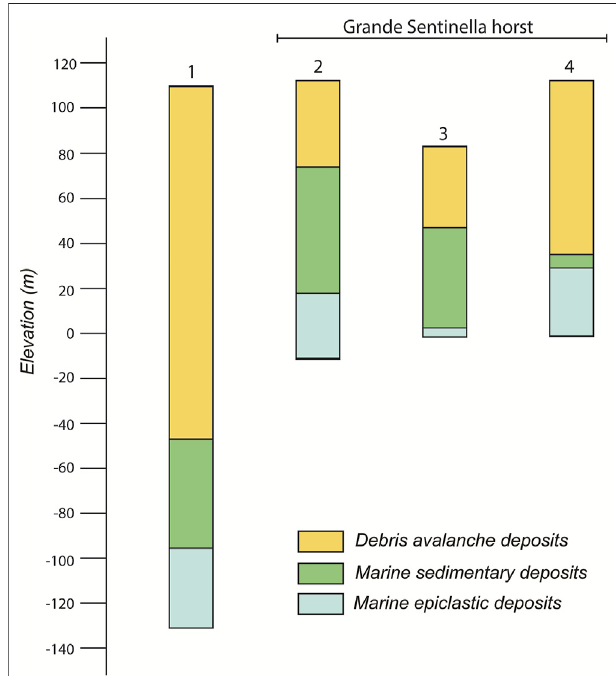
FIGURE 3 | Stratigraphy inferred from geothermal wells (1 – 4) located betweenMaio,LaRita,and GrandeSentinellasector(A – A ’ section, Figure2 ). The interpretation of stratigraphy highlights the uplift of the oldest marine deposits (caldera fi lling sediments) in the Grande Sentinella sector. The location of the wells is indicated in Figures 2 , 4 (see text for